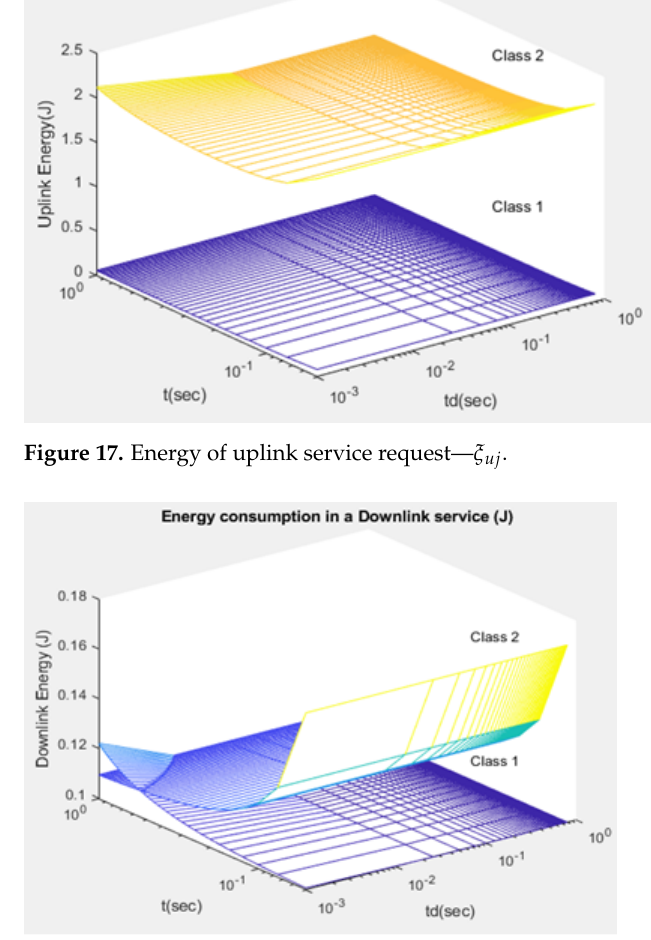
Figure 18. Energy of downlink service request— ξ dj .